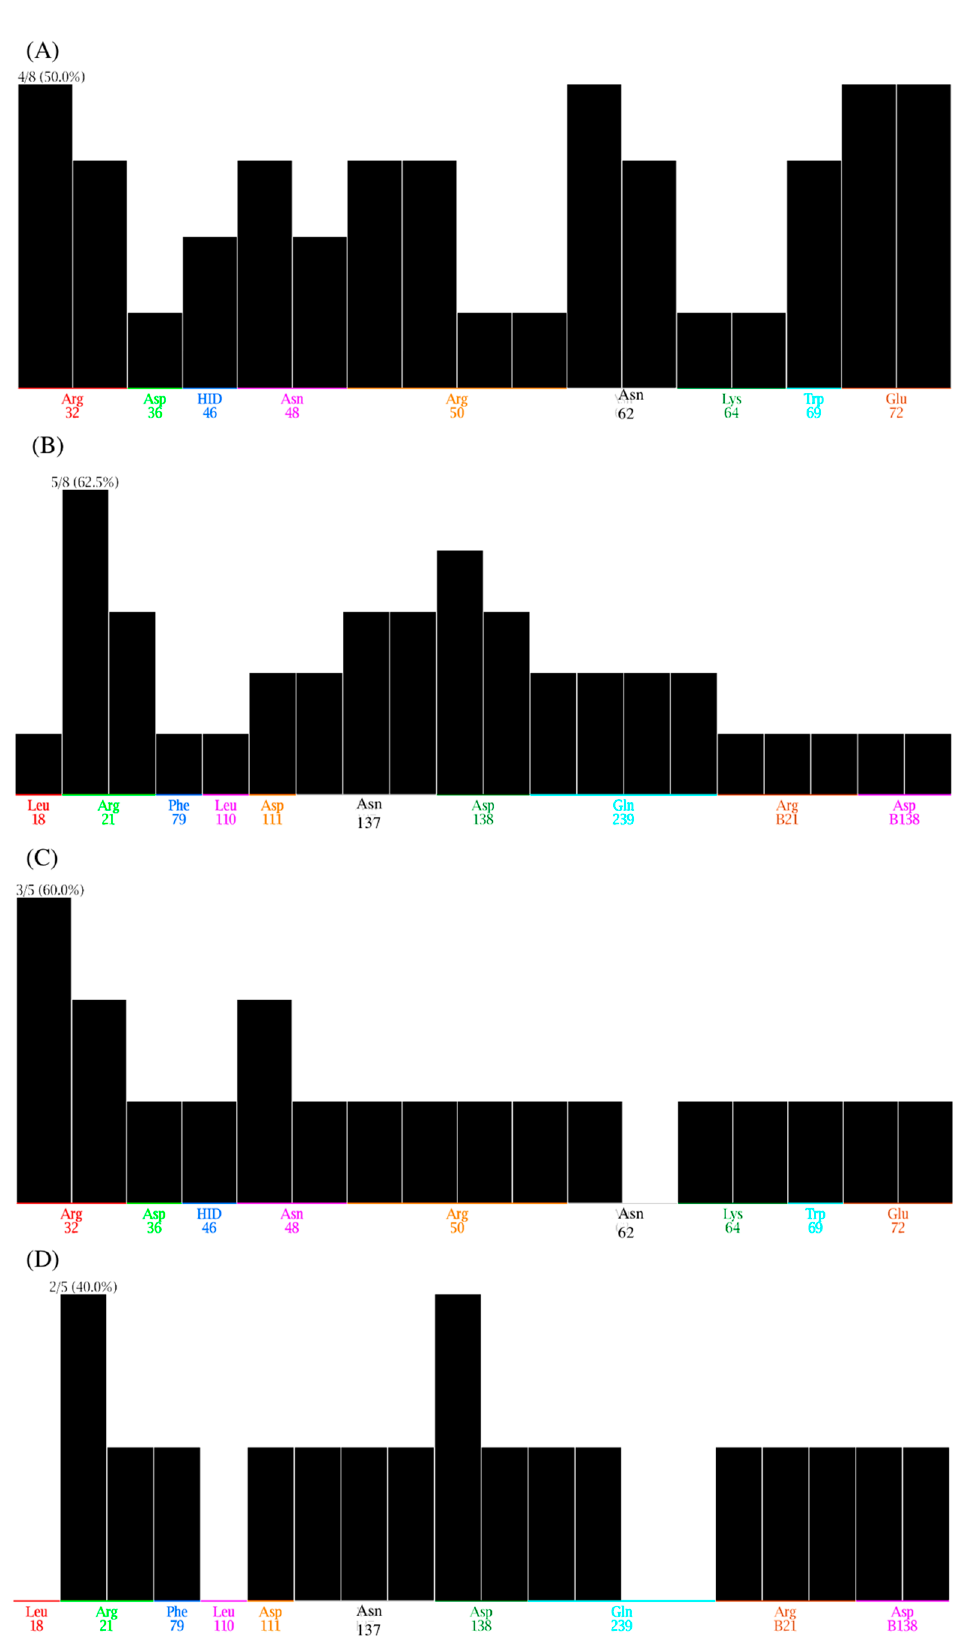
Figure 9. Population histogram of PLIF results displaying the number of ligands ( y -axis) with which each residue (plotted in the x -axis) interacts. Population display of ( A ) top-scoring inhibitors in Gal-3 protein, ( B ) top-scoring inhibitors in Spike protein, ( C ) dual inhibitors in Gal-3 protein and ( D ) dual inhibitors in Spike